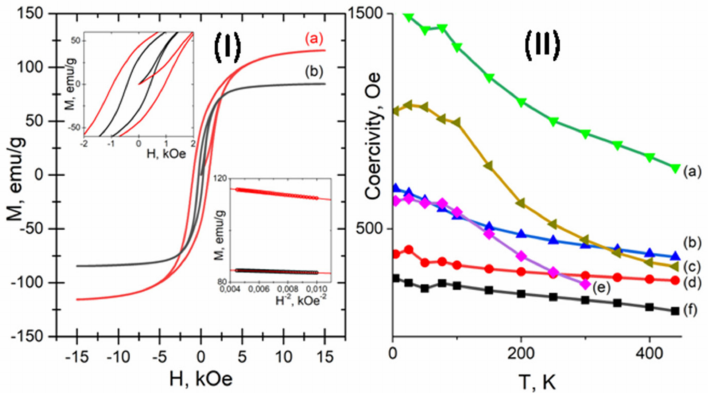
Figure 6. M(H) hysteresis loops at 300 K for the reduced samples (left insertion, M(H) near the origin; right insertion, high-field magnetization behavior in 1/H2 coordinates with linear regression): Co2Ni1 ( a ); Co1Ni2 ( b ) ( I ). Temperature dependencies of coercivity (HC(T)) for the samples: Co2Ni1_W8 ( a ); Co1Ni1_W8 ( b ); Co_W8 ( c ); Co1Ni2_W8 ( d ); Co_AC ( e ); Ni_W8 ( f ) ( II